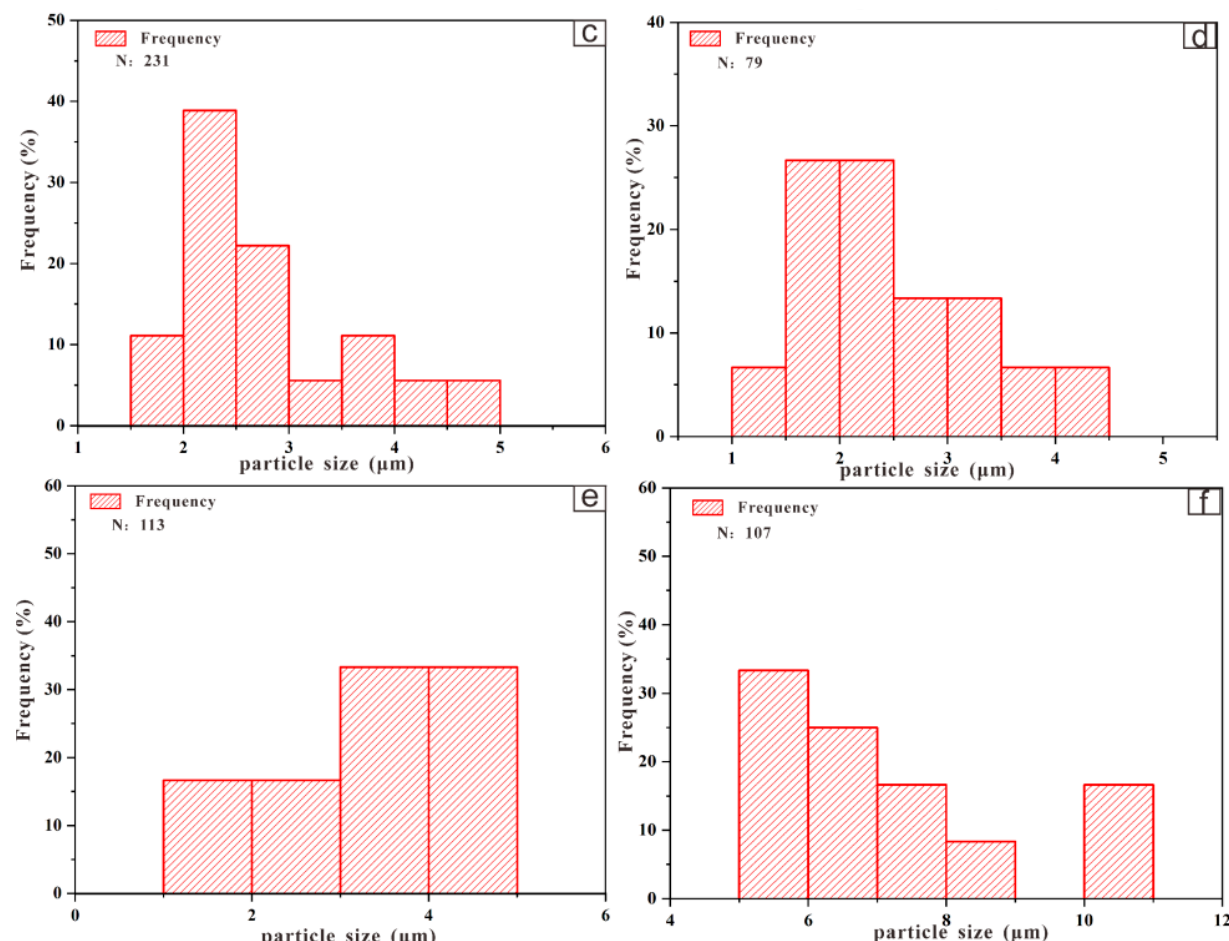
Figure 3. Histograms of the barite particle size with different morphology. The barite was synthesized using a mixed solution of 0.03 mol/kg Na 2 SO 4 and BaCl 2 with a ratio of 2:8 at 200 ◦ C. ( a ) plate-shaped ( b ) rod-shaped ( c ) granular ( d ) dendritic ( e ) T-shaped ( f ) X-shaped. N: statistic.